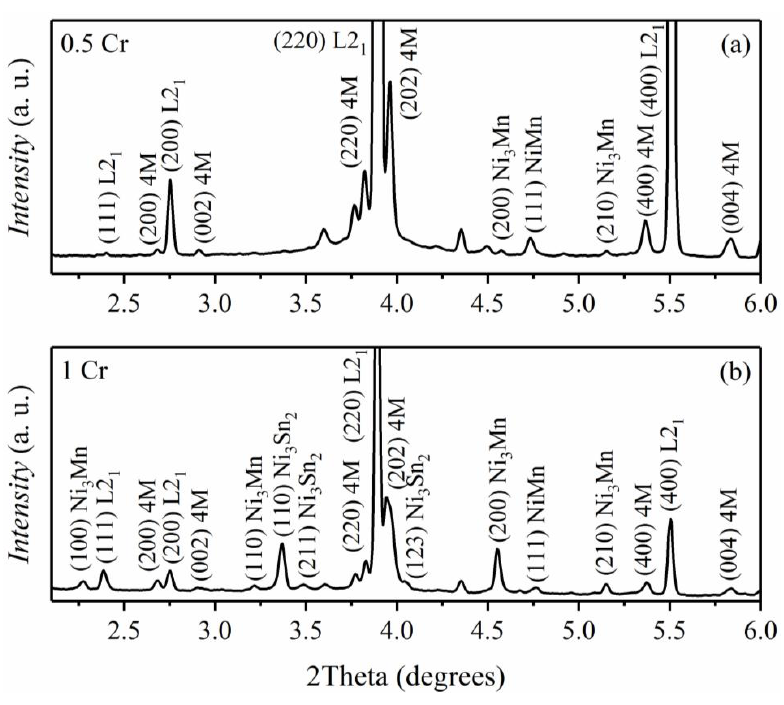
Figure 2. Integrated diffraction patterns recording the synchrotron X-ray intensity as a function of 2-Theta angle for the 0.5 Cr ( a ) and 1 Cr ( b ) alloys at room temperature.